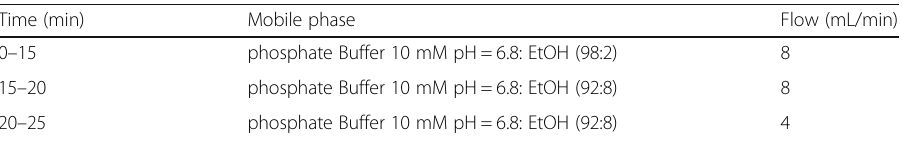
Table 1 Conditions of HPLC for